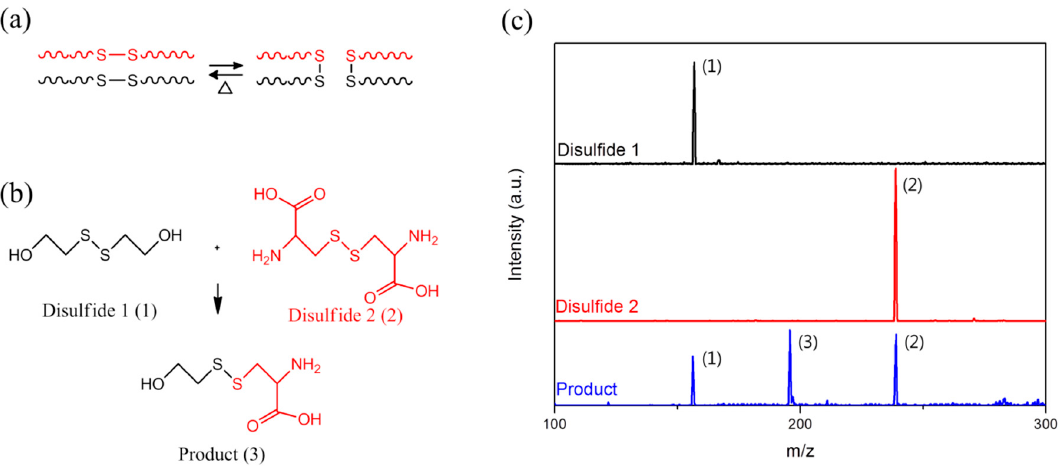
Figure 2. ( a ) Concept of the disulfide metathesis reaction. ( b ) Scheme of the disulfide metathesis reaction by Disulfide 1 and Disulfide 2. ( c ) LC/MS spectra for the disulfide metathesis reaction.